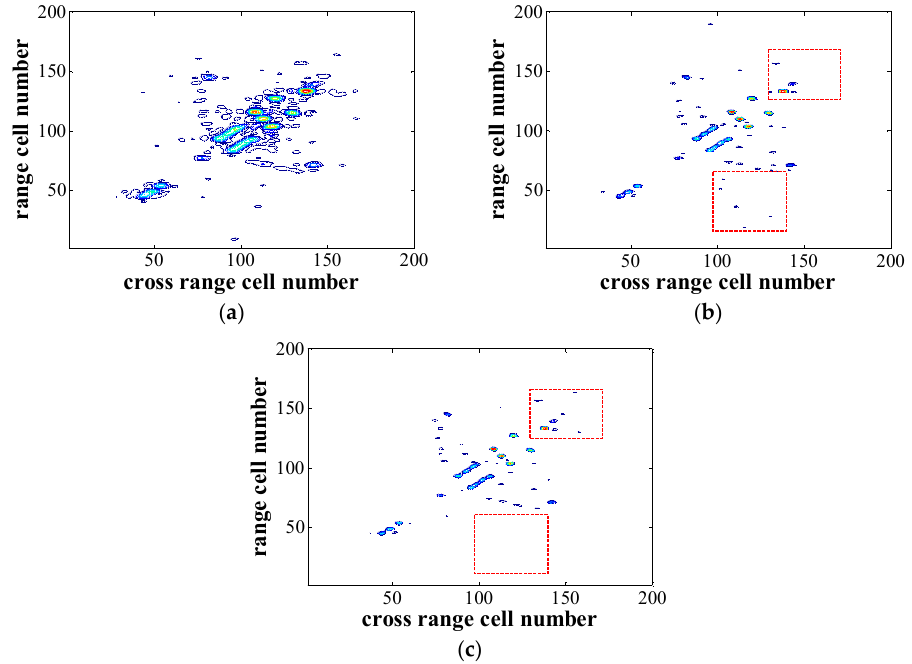
Table 2. System model parameters for data “B-727”.